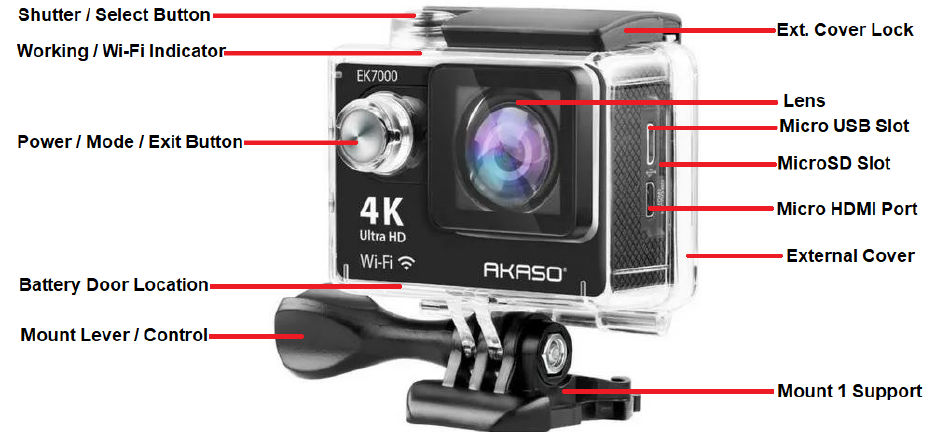
Figure 13. The AKASO EK7000 camera utilised in the experiment with its part labelled. It is used to monitor the motion of water waves against the floating structure inside the wave tank or flume used.